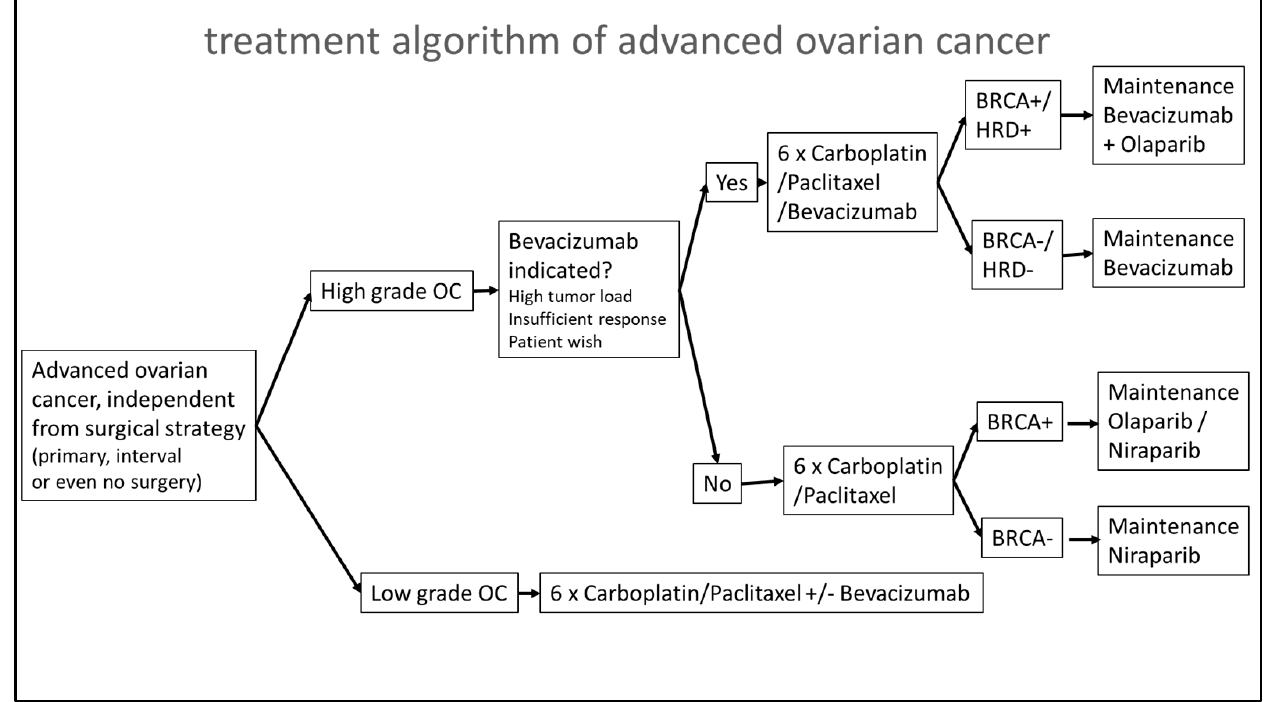
Figure 5. Treatment algorithm for maintenance therapy of patients with advanced ovarian cancer based on clinical and molecular biological parameter.